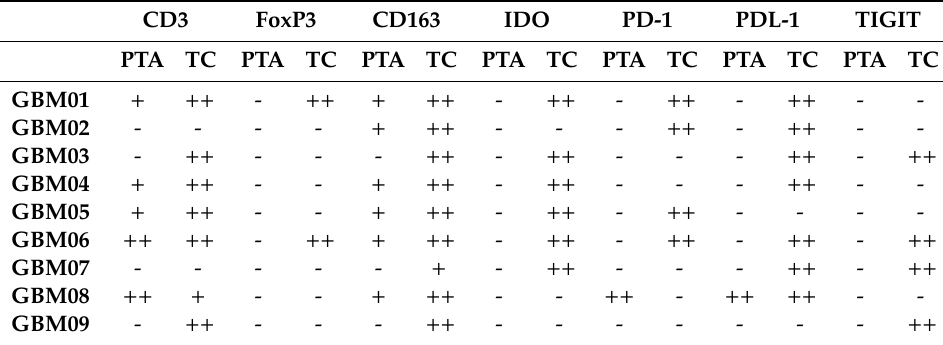
Table 2. Immune cell distribution in periphery and tumor